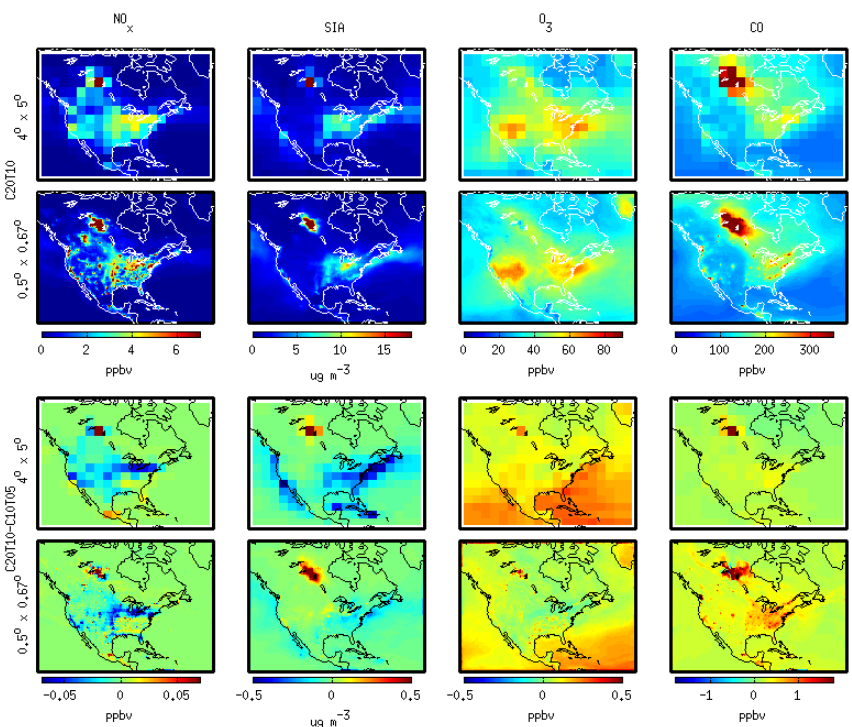
Figure 3. Sensitivity of simulated species to changes in operator duration (C20T10 to C10T05) at two different horizontal resolutions over North America (global 4 ◦ × 5 ◦ , and nested 0.5 ◦ × 0.67 ◦ simulations). The upper two rows contain monthly mean ground-level concentrations simulated with the C20T10 operator duration for 4 ◦ × 5 ◦ (top row) and 0.5 ◦ × 0.67 ◦ (second row) resolutions. The two lower rows contain the monthly mean differences (C20T10 minus C10T05) for 4 ◦ × 5 ◦ (third row) and 0.5 ◦ × 0.67 ◦ (bottom row) resolutions. Each column from left to right represents nitrogen oxides (NO x ), secondary inorganic aerosols (SIA), ozone (O 3 ), and carbon monoxide (CO).